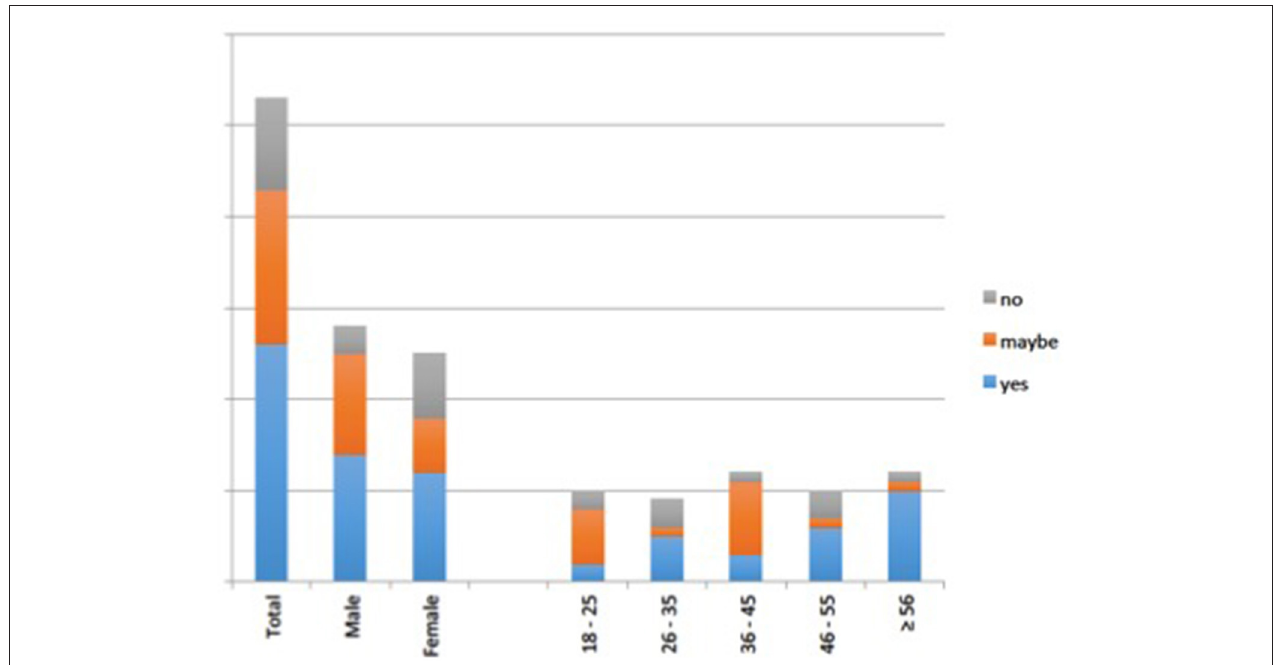
FIGURE 1 | Willingness by respondents to take COVID-19 vaccination against gender and age.